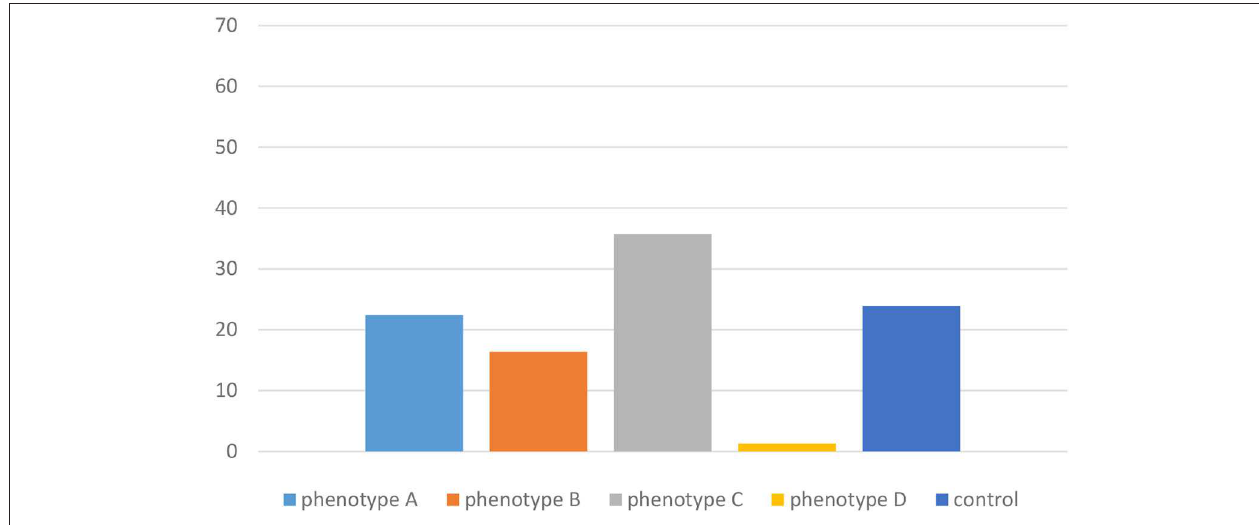
FIGURE 1 | Frequency (%) of positive TPOAbs in different PCOS phenotypes and the control group.